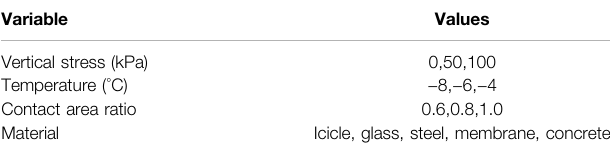
TABLE 2 | Parameters considered in the tests.